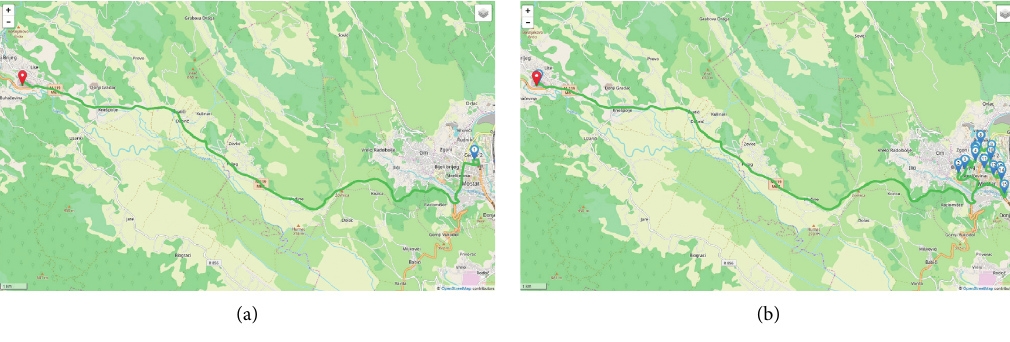
Figure 4: Example of divided